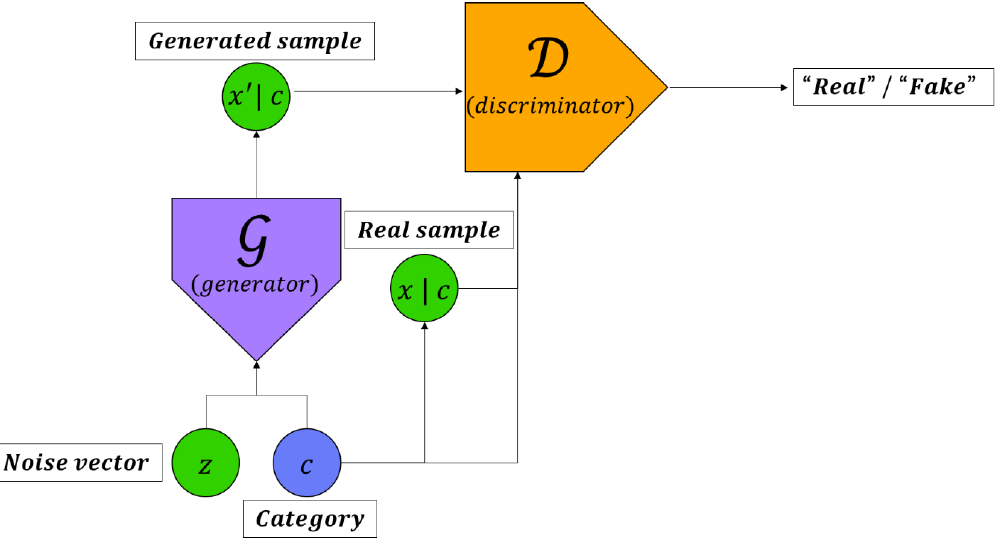
Figure 2. Conditional adversarial network.